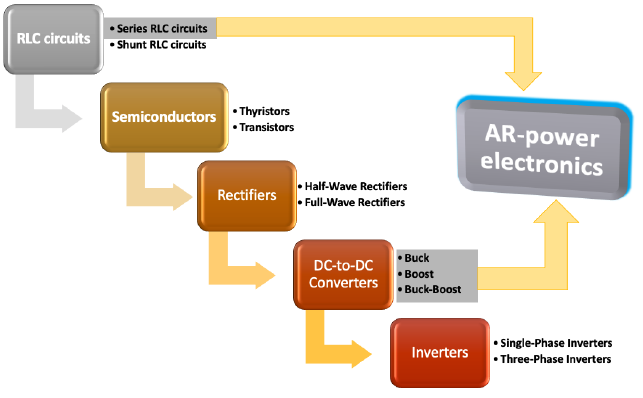
Figure 1. Power electronic